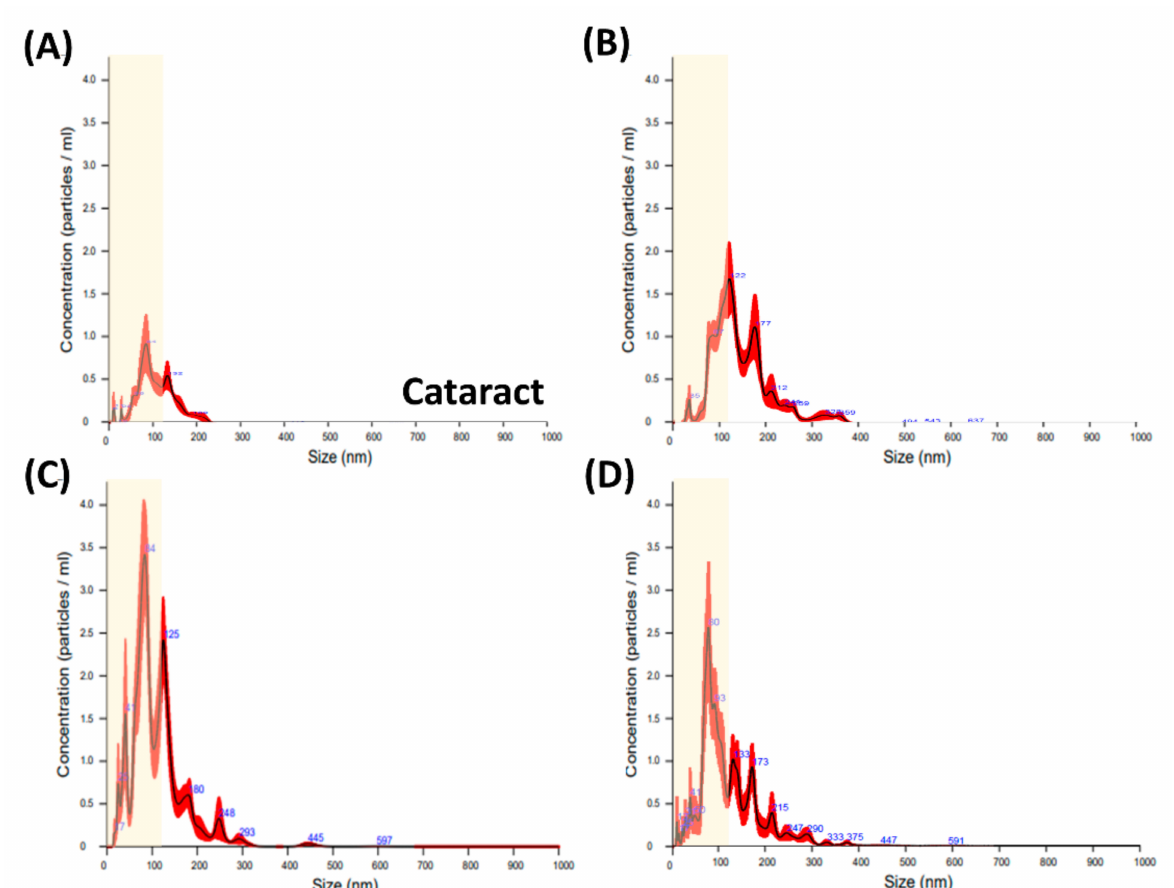
Figure 4. Size distribution of extracellular vesicles from the aqueous humor. The distribution of particle size in the aqueous humor was analyzed using nanoparticle tracking analysis (NTA). The aqueous humor was isolated from the anterior chamber of the patients with eye diseases, including ( A ) cataracts (as the control group), ( B ) age-related macular degeneration (AMD), ( C ) polypoidal choroidal vasculopathy (PCV), and ( D ) central retinal vein occlusion (CRVO). The yellow regions show the range of exosomes (<120 nm) in each disease.